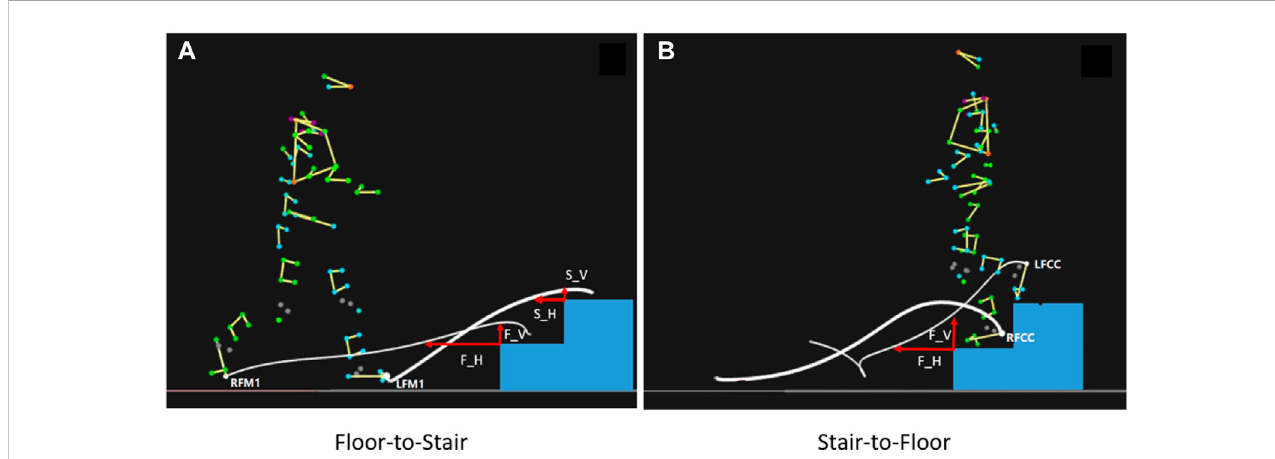
FIGURE 1 Stair transitions and Foot-tread clearance (FC). (A) : Floor-to-Stair transition; (B) : Floor-to-Stair transition. F_H: First step horizontal FC; F_V: First step vertical FC; S_H: Second step horizontal FC; S_V: Second step vertical FC. LFM1, RFM1: left and right fi rst metatarsal head; LFCC, RFCC: left and right heels.